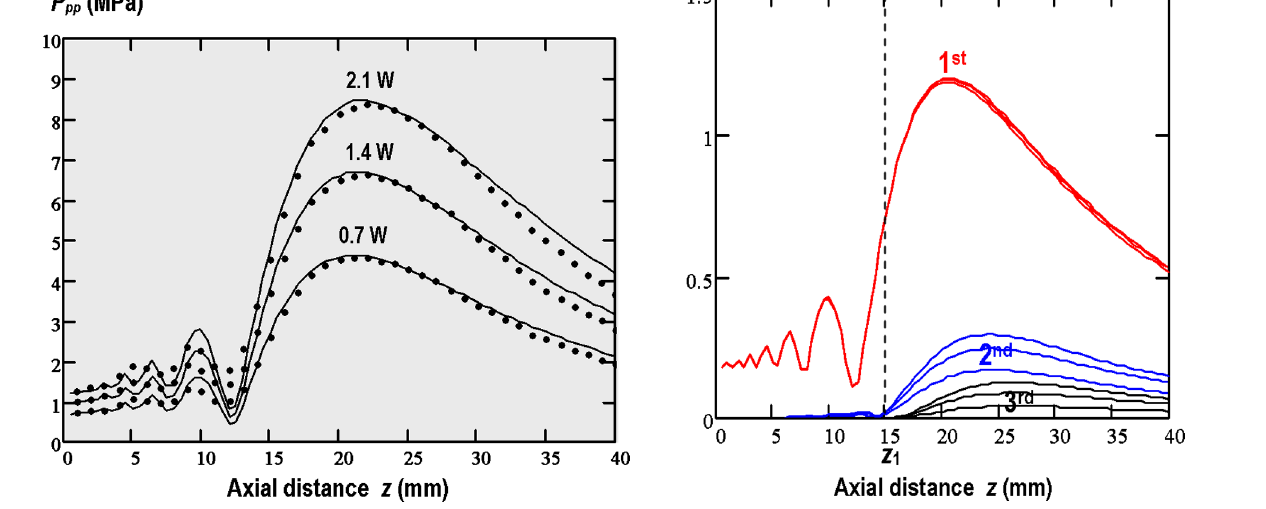
Figure 3. Axial peak-peak pressure variations in the pulsed focused nonlinear acoustic beam produced in water by 20- cycle tone bursts with 0.2 duty-cycle and the average acoustic power of 0.7 W, 1.4 W and 2.1 W. Calculated (solid lines) and measured (points) results.